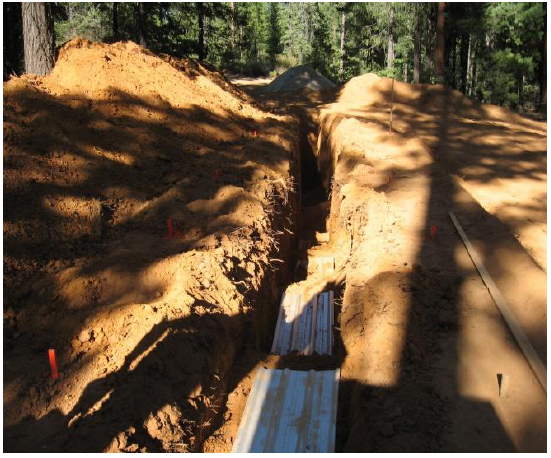
Figure A1. Target ground penetrating radar (GPR) imaging objects, tin roofing sheets, were buried at various depths. The experiments provided ground truth GPR data for hardware to software comparison [1,4].